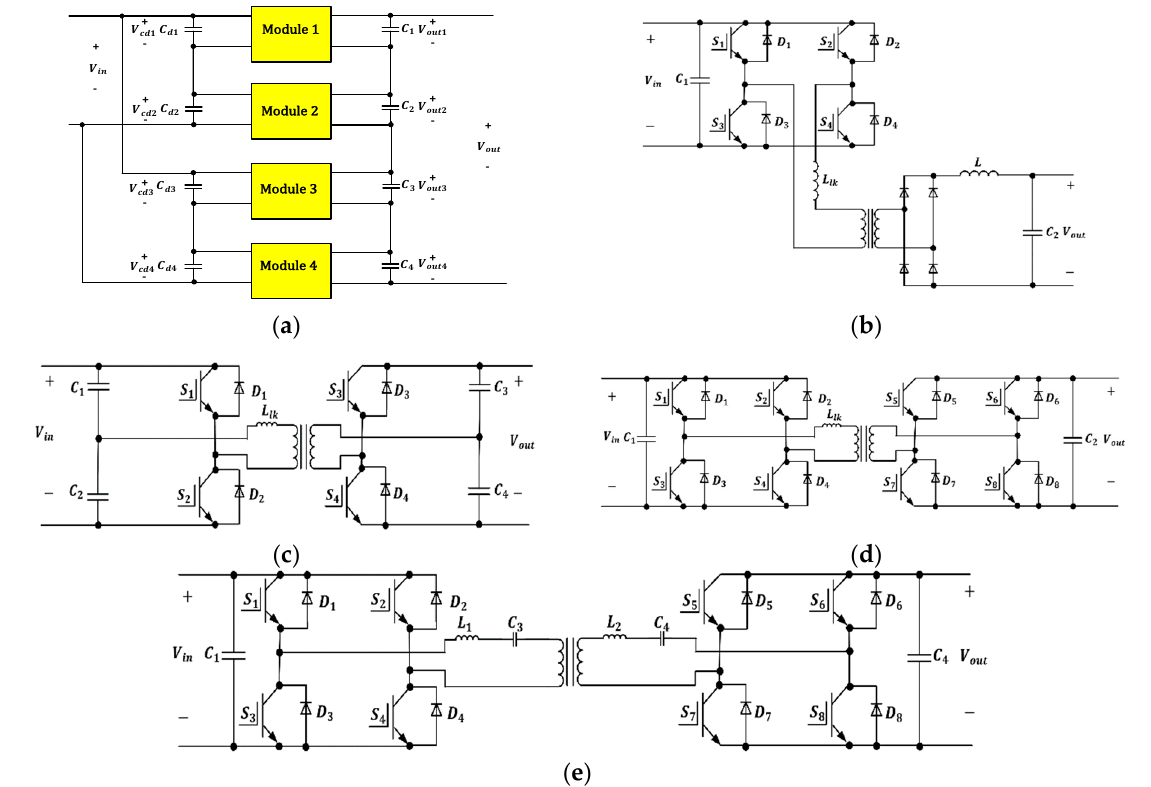
Figure 13. Multimodule DC-DC converter possible configurations: ( a ) Generic multimodule DC-DC converter; ( b ) FB circuit configuration; ( c ) HB circuit configuration; ( d ) DAB circuit configuration; ( e ) DAB DC-DC converter-based resonant topology.